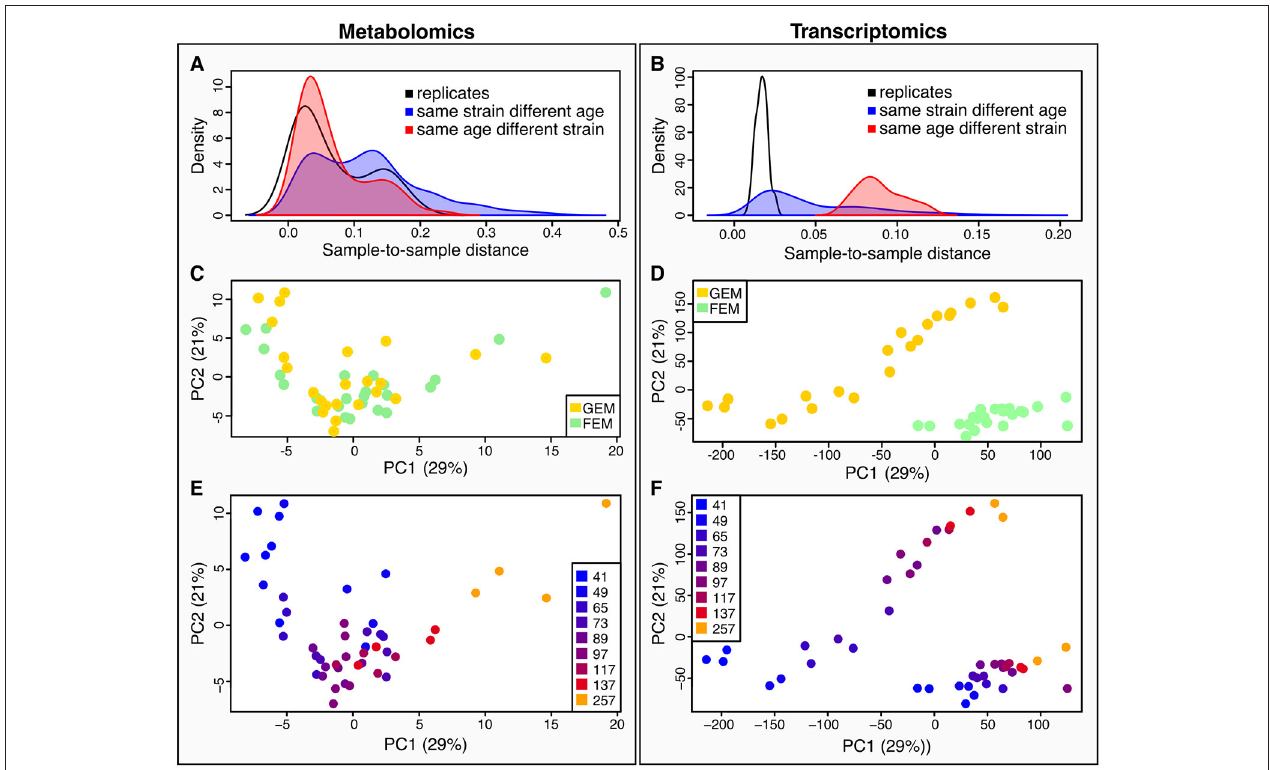
FIGURE 2 | Characteristics of between-sample variability compared between metabolomics and transcriptomics datasets. (A,B) metabolomics (A) , and transcriptomics (B) , show density plots of the distributions of pairwise sample-to-sample distances as grouped by samples that were replicates (black line), or shared their age (but not strain) (red line and shaded area), or shared their strain (but not age) (blue line and shaded area). The density distribution being shifted toward the left in these plots means that the samples were more similar (had a lower distance). These plots show that for the metabolomics dataset (A) , samples with the same age but different strains were closer than those with the same strain but different ages, while the opposite is true for the transcriptomics (B) . This plot also illustrates that there is greater technical variance in the metabolomics dataset than for the transcriptomics. (C,D) we conducted Principal Components Analysis (PCA) across the two datasets [ (C) , metabolomics; (D) transcriptomics]. We visualized the samples projected onto the space of the first two principal components. Samples are colored by strain–yellow for GEM, green for FEM. (E,F) the same principal components as in (C) and (D) are shown colored by age. [ (E) metabolomics; (F)